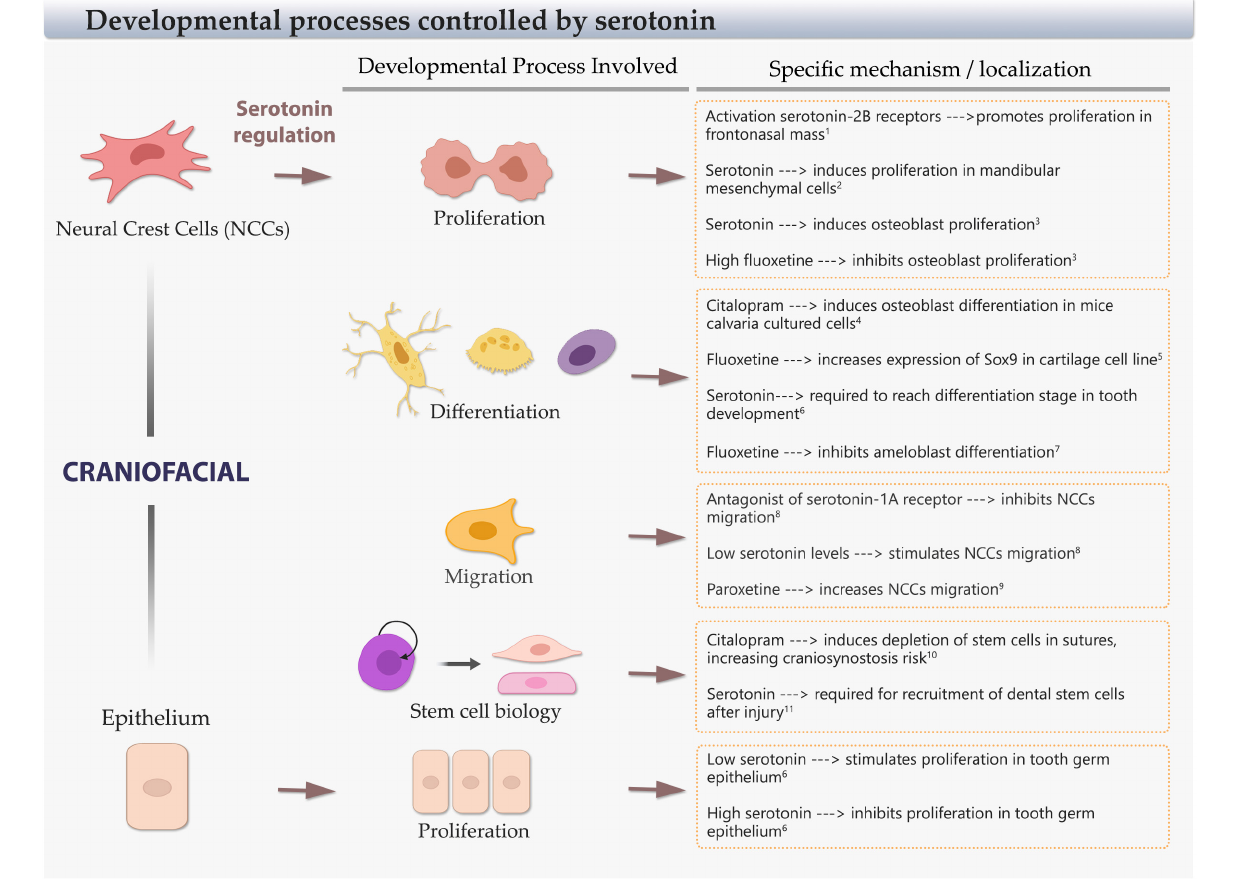
FIGURE 3 | Cellular developmental processes regulated by serotonin. Scheme of craniofacial neural crest cells (NCCs) and epithelial cells, and the main cellular processes controlled by serotonin: proliferation, differentiation, migration, and stem cell balance. The specific regulation, effect, and craniofacial territory/type of cell involved are included. References: 1 Bhasin et al., 2004; 2 Buznikov et al., 2001; 3 Gustafsson et al., 2006; 4 Cray et al., 2014; 5 Miyamoto et al., 2017; 6 Moiseiwitsch and Lauder, 1996; 7 Riksen et al., 2010; 8 Moiseiwitsch and Lauder, 1995; 9 Vichier-Guerre et al., 2017; 10 Durham et al., 2019; 11 Baudry et al., 2015.